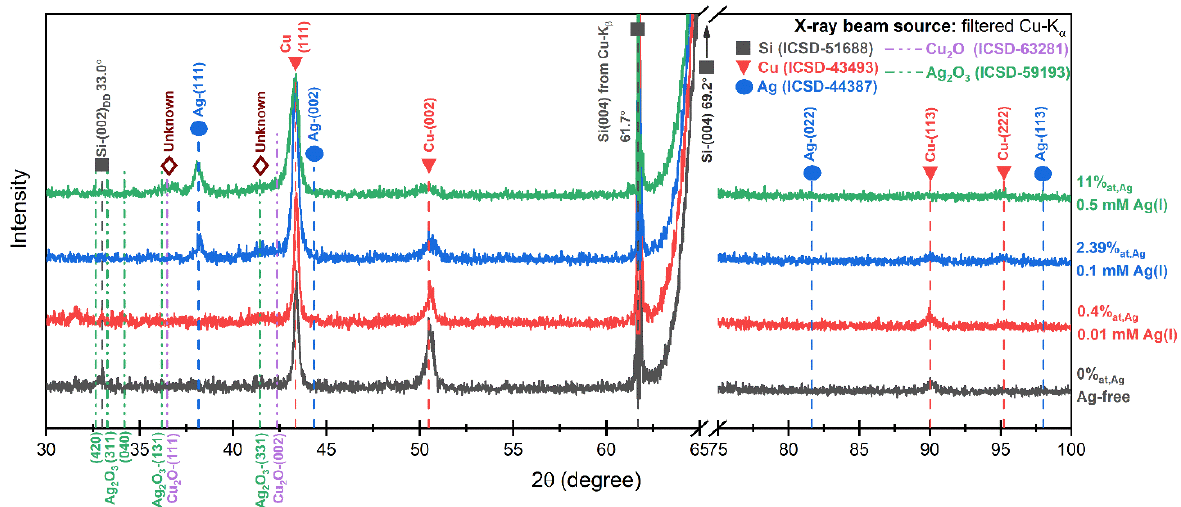
Figure 4. The morphology of thick films deposited from 0.5 M H 2 SO 4 + 10 mM CuSO 4 solutions with addition of 0~0.1 mM AgNO 3 at n-Si(001) substrate, nominal thickness of films is about 170 nm.